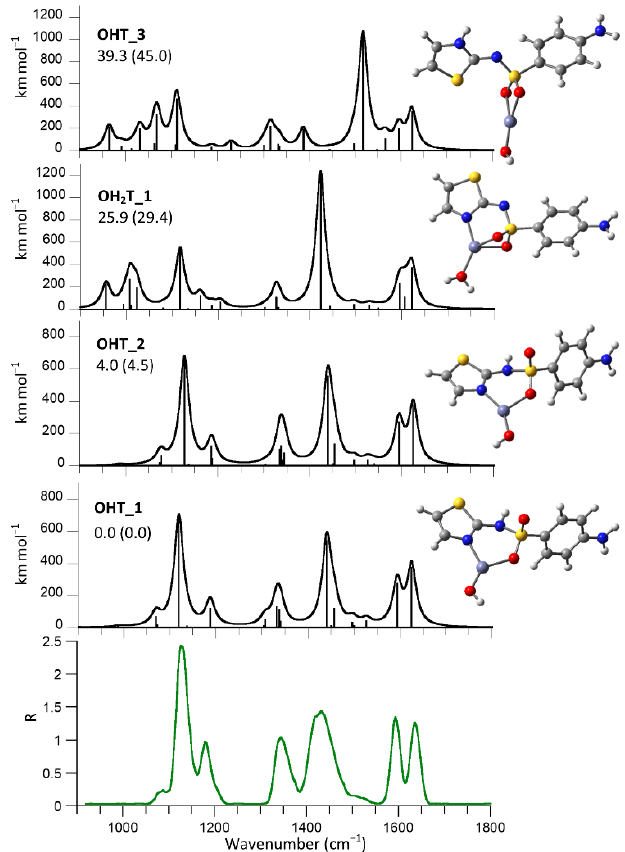
Figure 3. IRMPD spectrum of Zn(H 2 O+STZ − H) + (bottom panel, green profile) compared with calculated IR spectra of selected isomers, the optimized structures of which are reported on the right. Relative free energies (enthalpies) at 298 K are reported in kJ mol − 1 . Calculations are at the B3LYP/6-311+G(2df,pd) (S = 6-311+G(3df)) level. Computed harmonic frequencies are scaled by a factor of 0.974, except those regarding S-X stretching modes, which are left